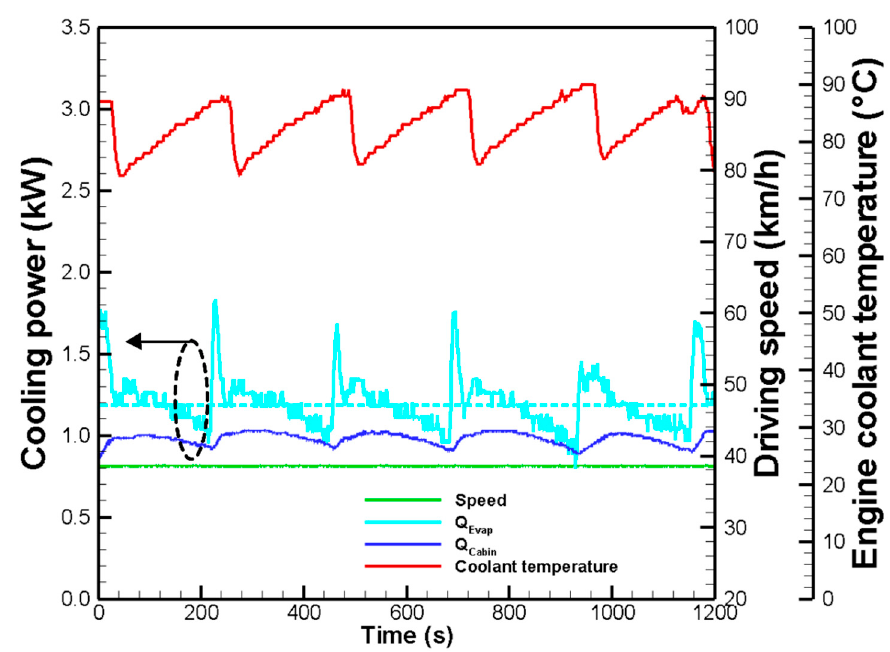
Figure 6. Wind tunnel test (Test no. 2) results of the prototype at constant vehicle speed and 25 °C ambient temperature.